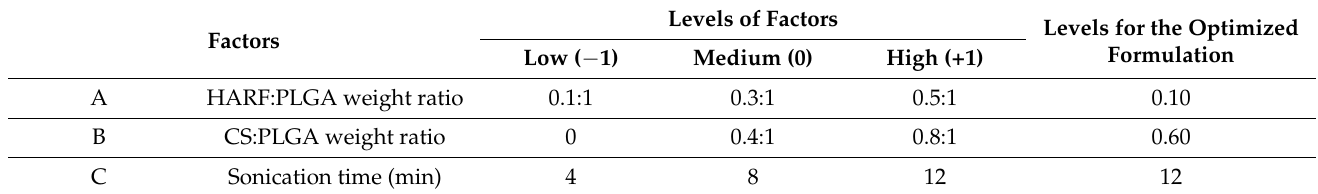
Table 2. Independent variables and their relevant levels of 3 3 BBD for H/CS/PLGA NPs, and their levels relative to the optimized H/CS/PLGA NPs